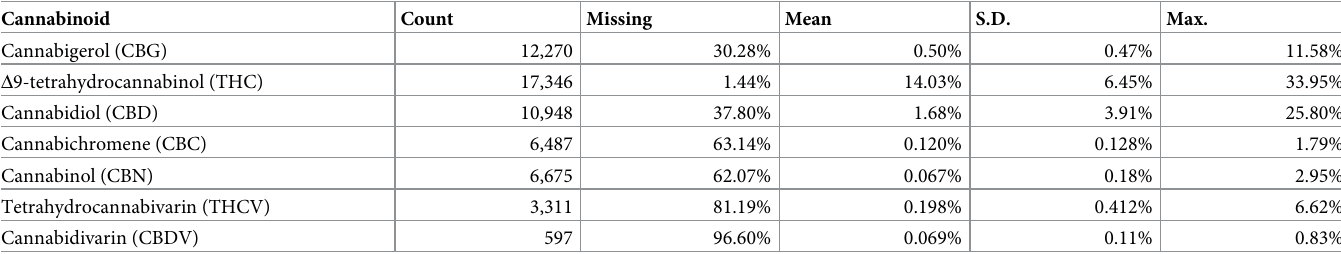
Table 1. Cannabinoid distribution for 17,612 unique cultivars.